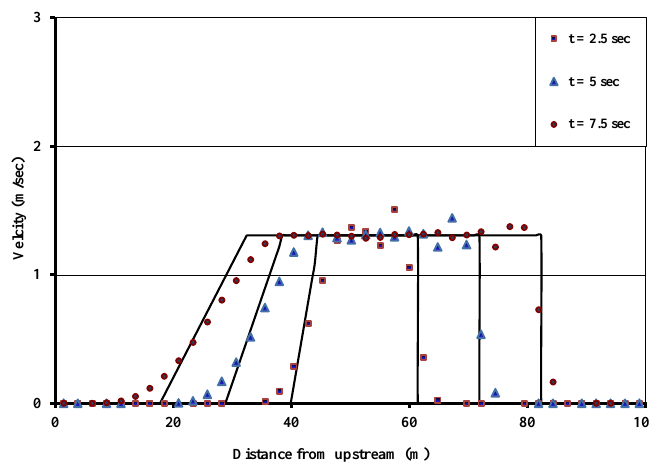
Figure 3. Longitudinal velocities along the entire domain compared with the analytical